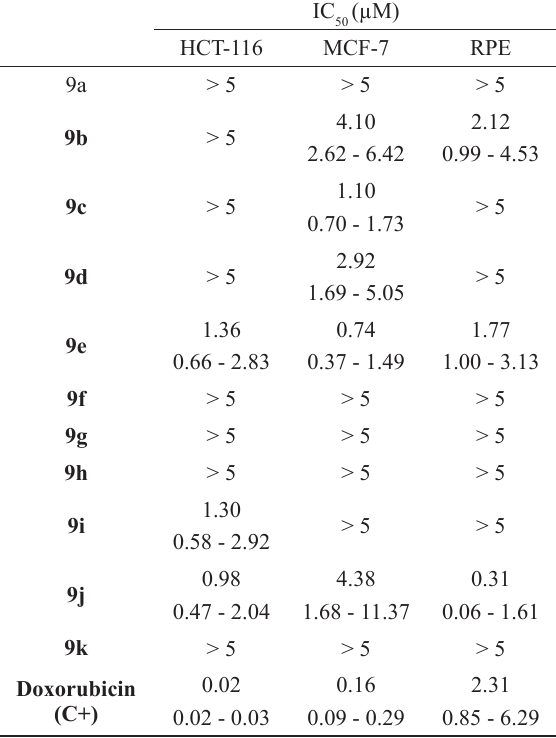
IC values presented in µM against 3 cell lines: HCT-116 50 (colon adenocarcinoma); MCF-7 (breast adenocarcinoma) and RPE (human non-tumor cell line from retinal epithelium) after 72 hours of